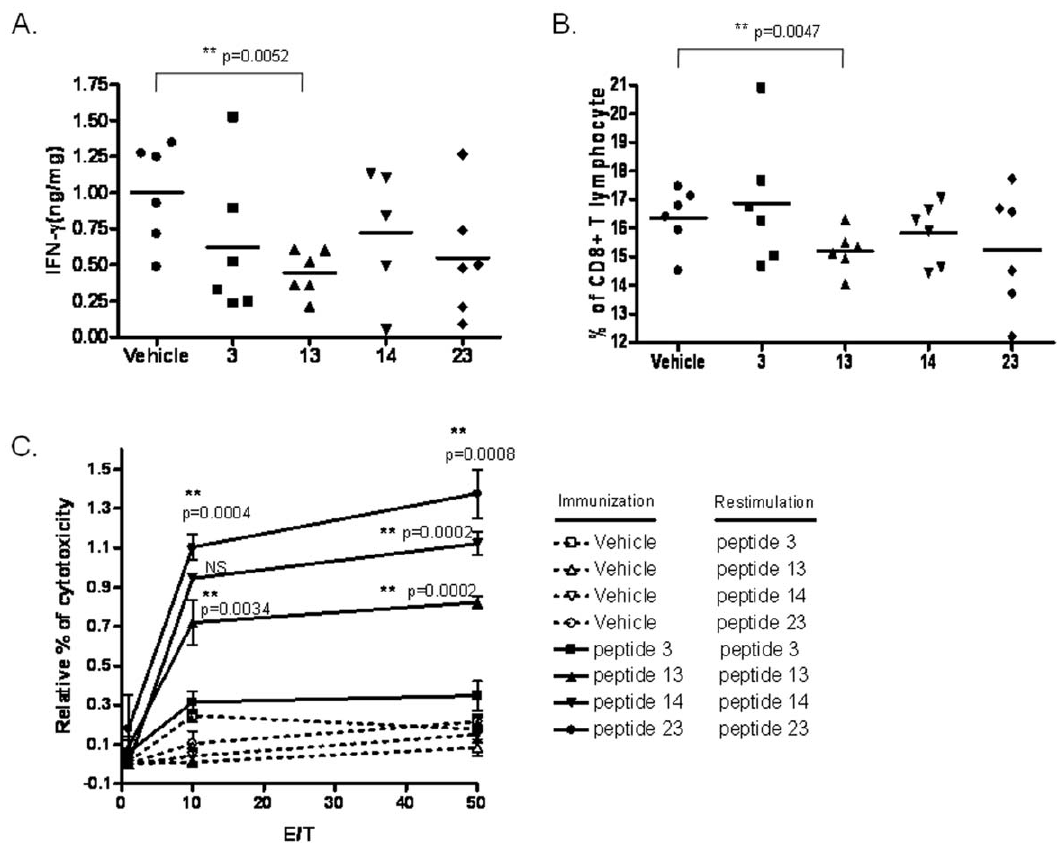
Figure 5. Induction of pulmonary IFN- c and CTL activity in peptide immunized transgenic mice challenged with RSV. At day 4 post RSV infection, lung homogenates were prepared and the following were measured. (A) IFN- c expression by ELISA, and (B) the number of CD8 + T cells in the lungs by flow cytometry using PE-cy5-labeled anti-CD8 antibody. (C). Enumeration of CTL activity in the lungs of mice immunized with CD8 N peptide epitopes and challenged with RSV. Effector lymphocytes isolated from the lungs of mice immunized with peptide 3 ( & ), peptide 13 ( m ), ) were cultured and supplemented with murine IL-2 in the presence of 2 m g of the same peptide for 5 days. In peptide 14 ( . ), or peptide 23 ( parallel, cultured pulmonary lymphocytes from vehicle-immunized mice were stimulated with 2 m g of peptide 3 ( % ), peptide 13 ( D ), peptide 14 ( h ), or peptide 23 ( o ), respectively, for 4 days. DCs isolated from the tibia of HLA-B6 mice were pulsed with 20 m g per mL of the individual peptides for 2 hours at 37 u C and labeled with CFSE and used as targets in the in vitro CTL assay. Un-pulsed DCs served as negative control. The viable effector cells were co-cultured with 10 4 peptide-loaded target DCs cells at effector:target ratios of 50:1, 10:1, and 0:1 for five hours. The cell mixtures were labeled with 7-AAD and analyzed by flow cytometry. Results are expressed as mean percentage of 7-AAD/CFSE positive cells normalized with un-pulsed DCs. Six mice were taken in each group. The result is a representative of two independent experiments.